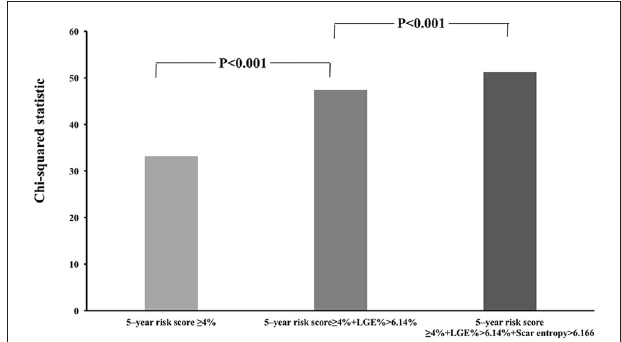
FIGURE 4 | Incremental value of scar entropy > 6.166 and LGE > 6.14% over the conventional 5-year sudden cardiac death (SCD) risk stratification score. The %LGE significantly improves the risk stratification of VAs when added to the 5-year SCD risk score ≥ 4% while scar entropy further significantly improved the %LGE-modified 5 year SCD risk stratification